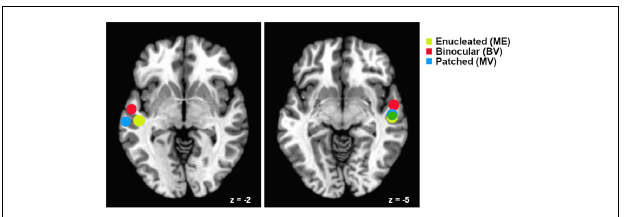
FIGURE 2 | Relative locations of superior temporal gyrus “audiovisual” regions of interest for each participant group. Regions are plotted as spheres (radius = 6 mm) centerd on the mean Talairach coordinates for each group. Left hemisphere regions are shown on an axial slice at Talairach z = –2 and right hemisphere regions are shown on an axial slice at z = –5. Mean coordinates for the Monocular Enucleation Group (ME) are shown in yellow, Binocular Viewing Controls (BV) in red, and eye-patched Monocular Viewing Controls (MV) in blue. Overlap of the right hemisphere ME and MV regions is shown in green.